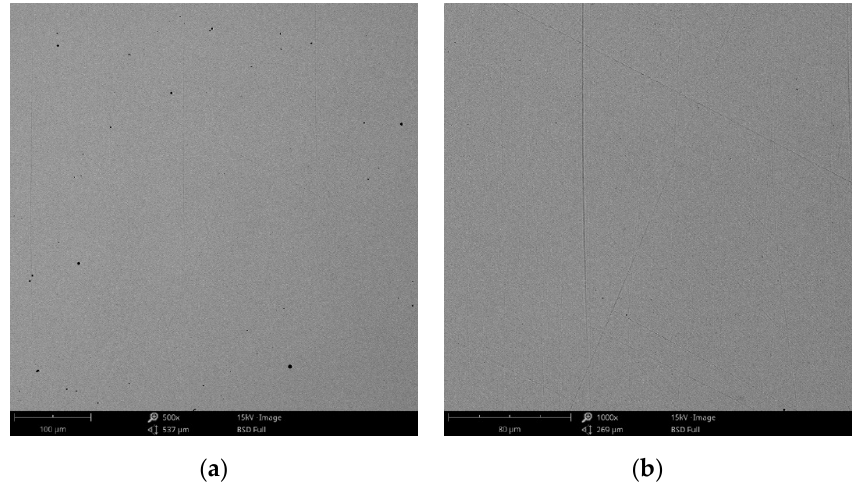
Figure 15. SEM images of the CCm-3 sample after corrosion tests at ( a ) 500×; ( b ) 1000×.